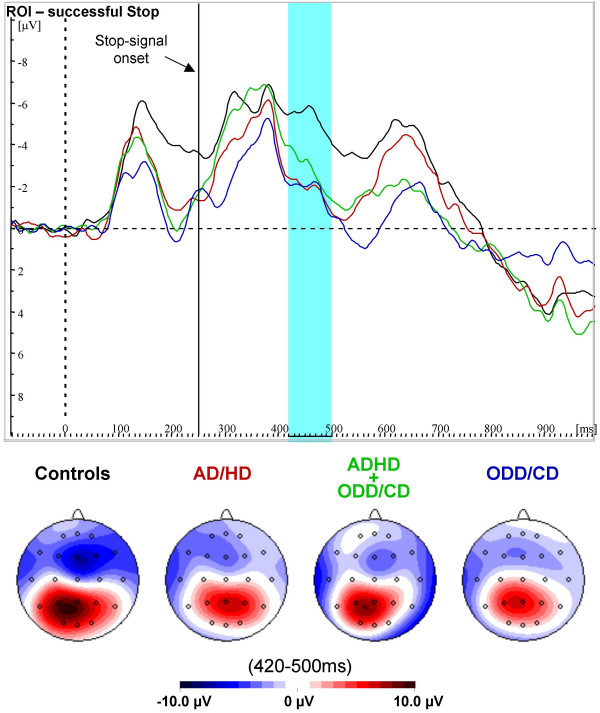
ERPs for successful Stop-trials. Grand-average waves in the region of interest and spline-interpolated maps for successful Stop-trials for normal controls (black), AD/HD (red), AD/HD+ODD/CD (green) and ODD/CD (blue). Only normal control children display a negative peak approximately 210 ms after onset of the Stop-signal.